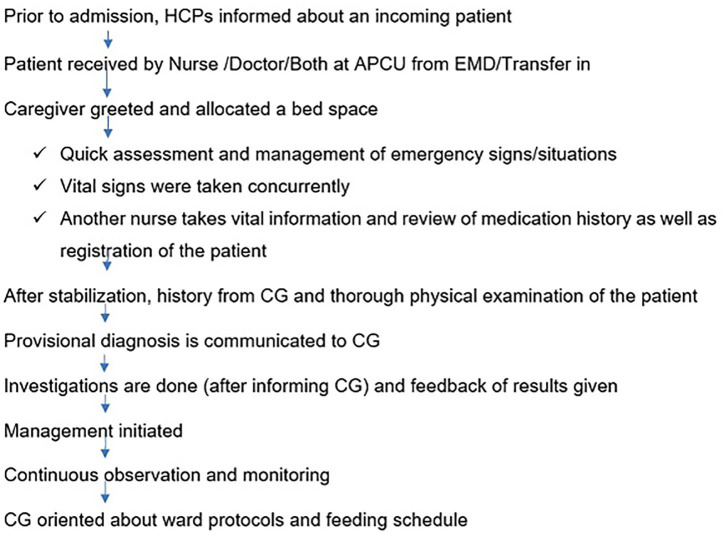
Admission process.